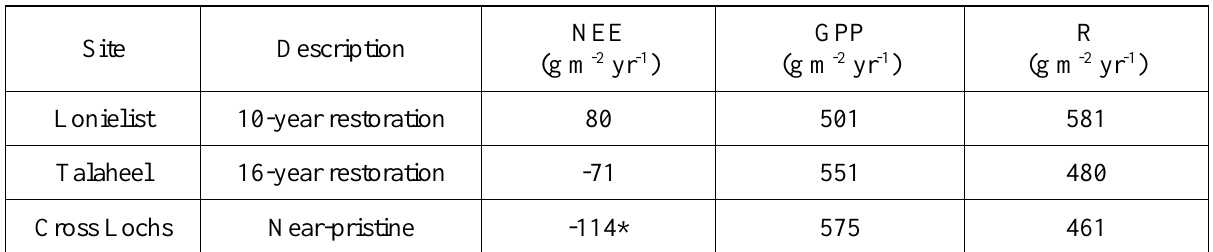
Table 1. Annual carbon dioxide (CO ) fluxes (expressed as CO -C) for Lonielist (restoration commenced in 2 2 2003/04), Talaheel (restoration commenced in 1997/98) and a near pristine blanket bog site *Values from the unmanaged site are a 6-year mean between 2008-2013 (Levy & Gray